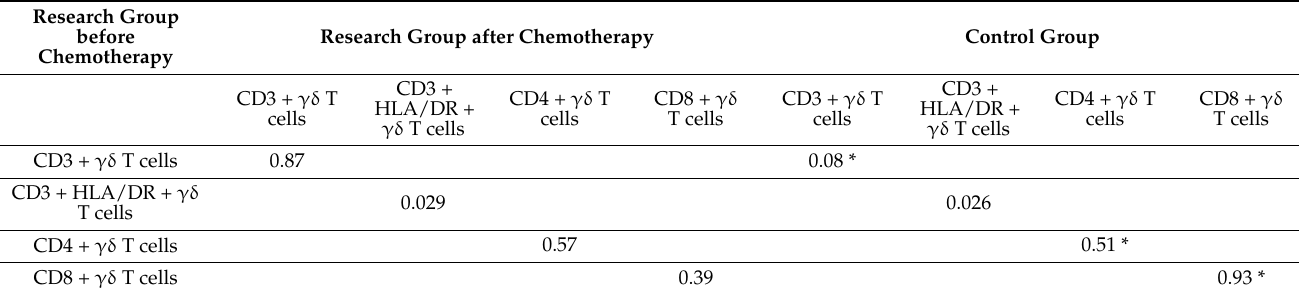
Figure 2. Decreased concentration of CD3 + HLA/DR+ γδ T cells among patients at disease presentation compared to the concentration of the lymphocytes after induction. Table 3. The results of statistical tests regarding the comparison of γδ T cells in two time points in the research group (Wilcoxon test) and between the research and study group (U Mann--Whitney test).